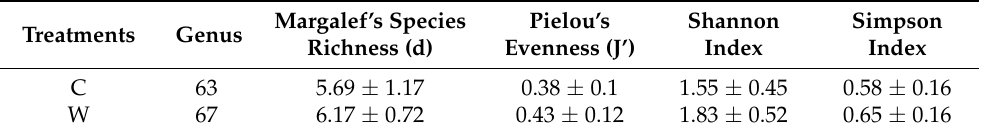
Figure 5. Microbial taxonomic identification in the gut of shrimp in control (C), and W5 (W) groups. Table 4. α -Diversity of the intestinal microbiota of shrimp in control (C), and W5 (W) groups. Values represent the mean diversity of triplicate replications within each group. n = 3.